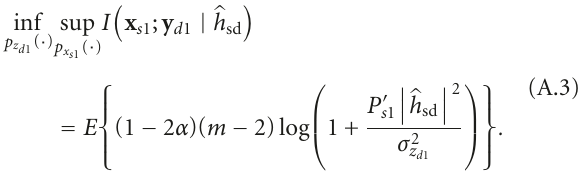
minimum bit energy, which is achieved at a nonzero value of SNR, decreases with increasing m and is achieved at a lower SNR value. Figure 16 shows the minimum bit energy for di ff erent relaying schemes with overlapped or nonoverlapped transmission techniques. We observe that the minimum bit energy decreases with increasing m in all cases. We realize that DF is in general much more energy-e ffi cient than